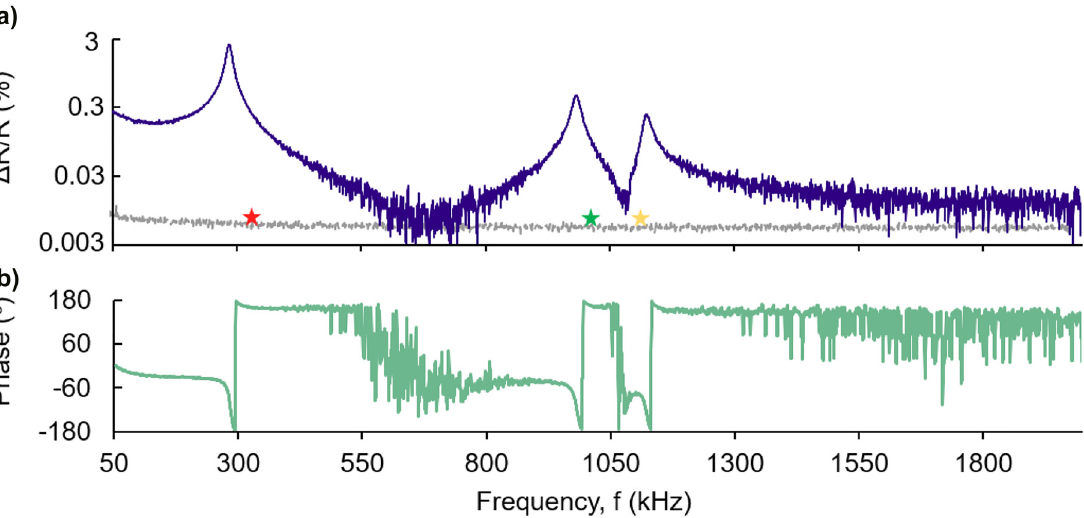
nanobeams as a function of the driving frequency. Figure 4: Reflection modulation of the defromable BaTiO 3 (a) Reflection spectrum of the plasmonic-ferroelectric nanostructure, blue line. Three mechanical resonances are recorded at 285 kHz, 983 kHz, and 1.13 MHz. Numerically calculated values are annotated with red, green and yellow star, respectively. Samples are biased at U : 2 V peak to peak. Reflection axis is in logarithmic scale. Grey line: the signal recorded for a reference sample without any BaTiO 7 V and V AC nanocrystal. (b) Corresponding phase spectra measured between the input (electric) and detected (optical)